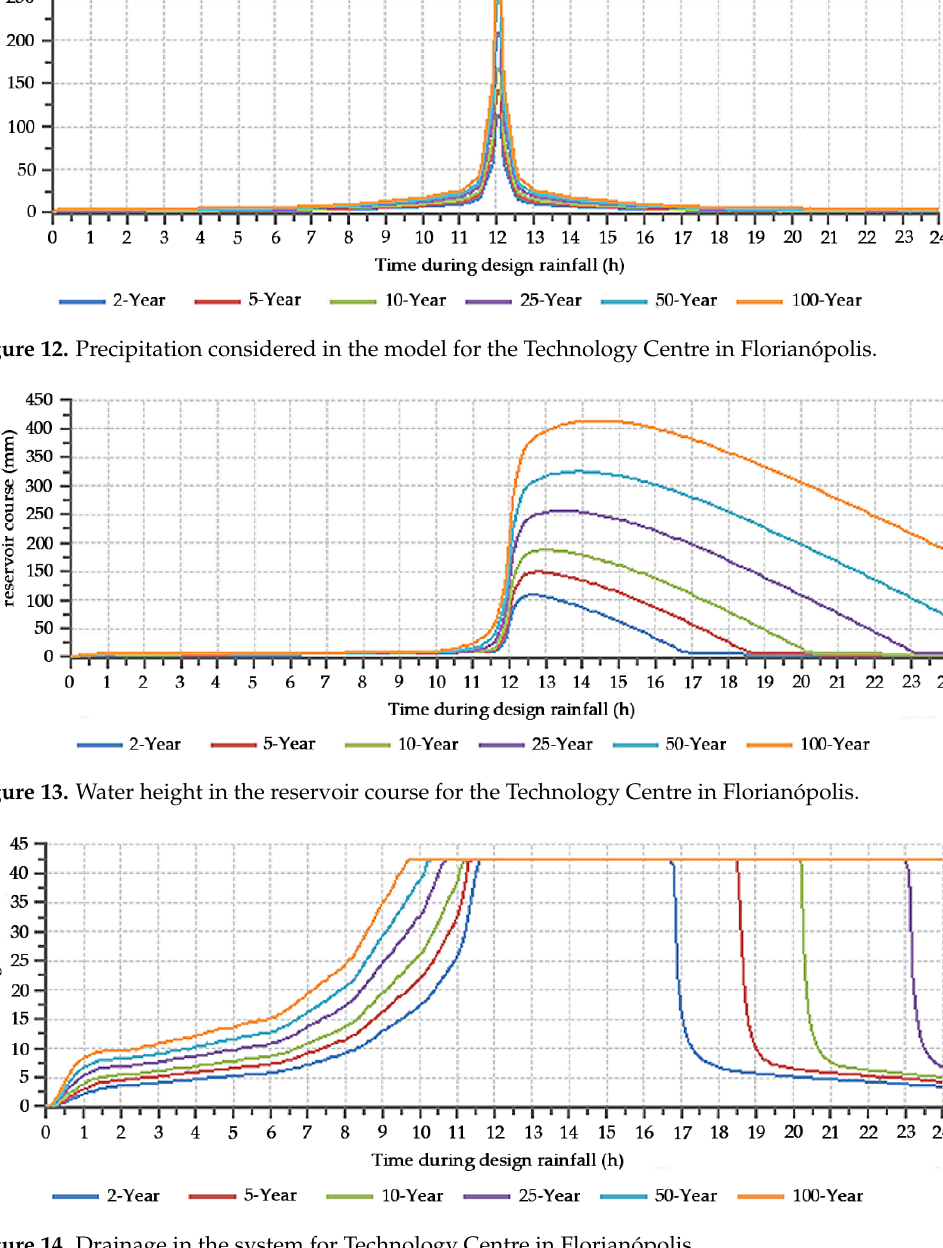
Figure 14. Drainage in the system for Technology Centre in